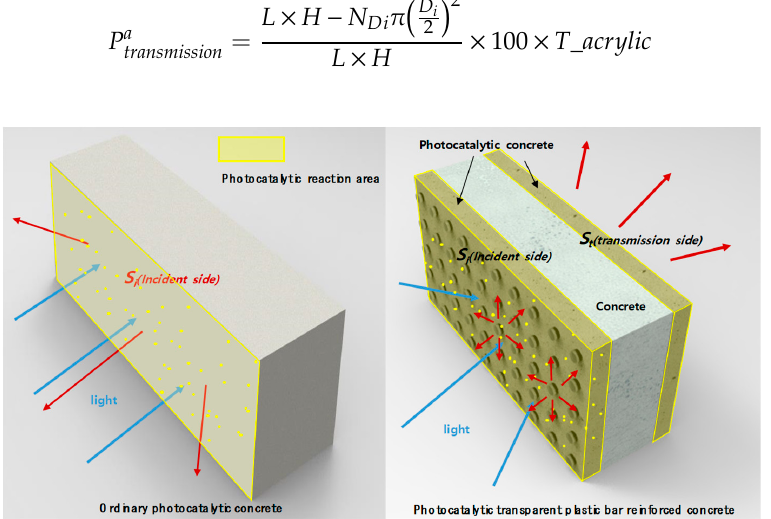
Figure 16. Comparison of ordinary photocatalytic concrete and photocatalytic transparent plastic bar reinforced concrete.